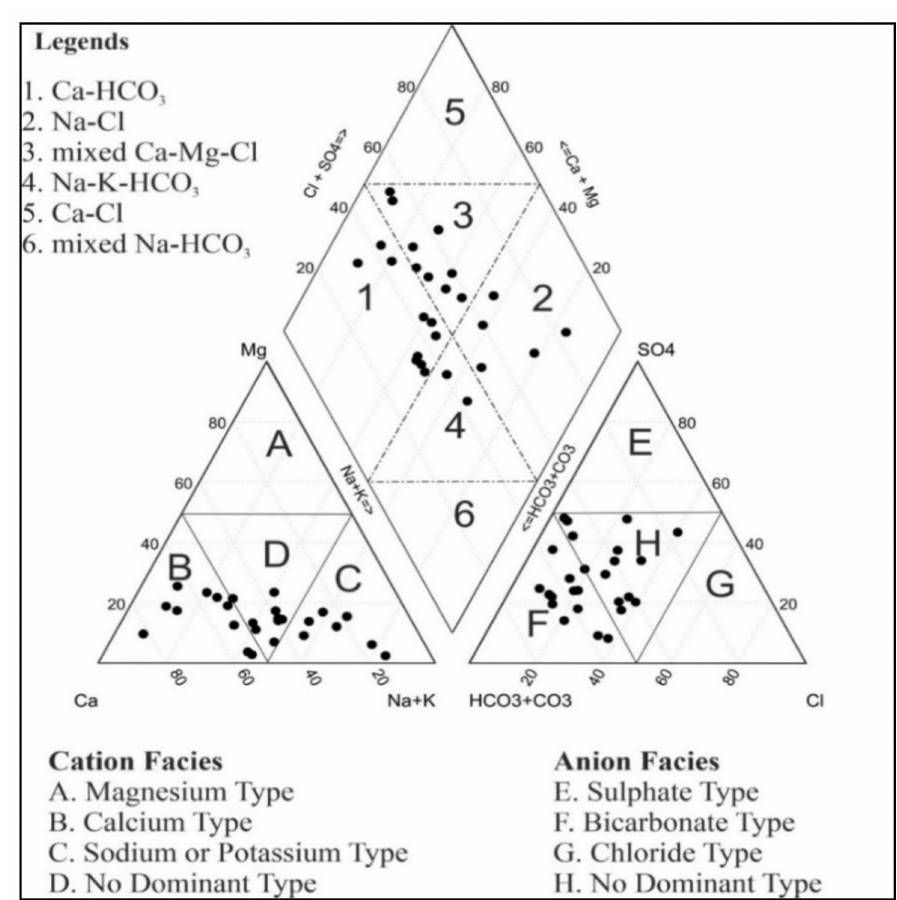
Figure 3. Piper trilinear diagram showing different hydrochemical facies in